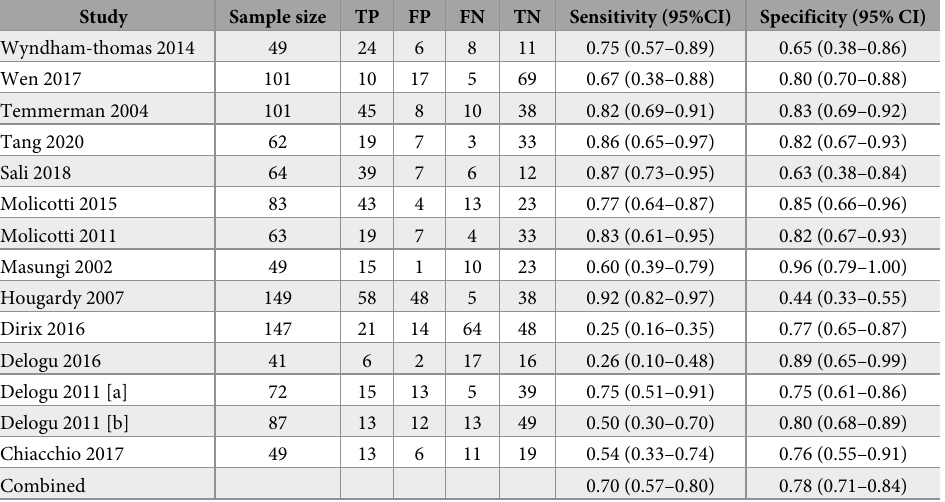
Table 2. Diagnostic performance of the HBHA-IGRA for discrimination of the LTBI and active